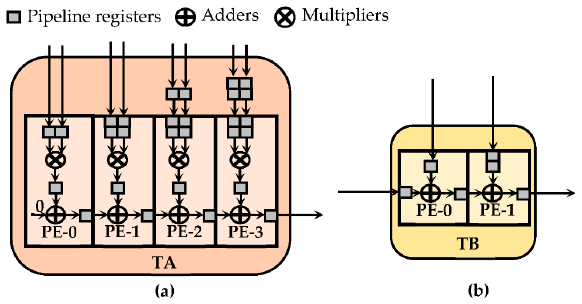
Figure 8. Example of PEs arranged in tiles: ( a ) TA with four Pes; ( b ) TB with two PEs.